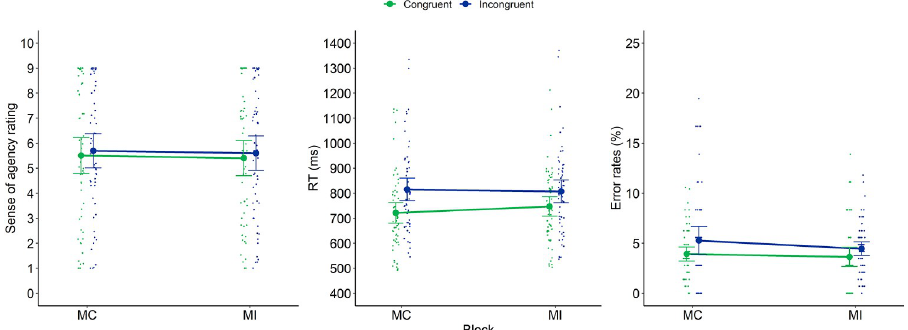
Fig 5. Sense of agency ratings (left panel), RTs (middle panel) and error rates (right panel) of Experiment 2 as a function of previous congruency and current congruency. Dots represent mean RTs for each participant in each condition (thus, each participant is depicted four times on this graph, once for each Previous × Current Congruency condition). Error bars represent 95% confidence intervals.